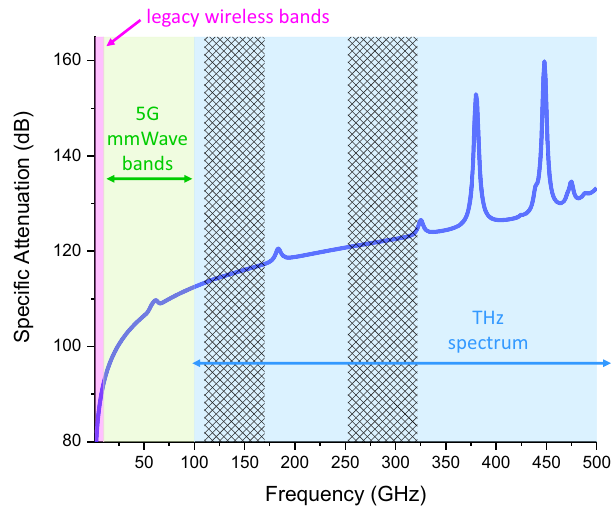
Fig.1|AtmosphereandFSPL. Theattenuationofapropagatingradiowavedueto bothfree-spacepathlossandatmosphericabsorption,foranassumedpropagation distance of 100 m, at a temperature of 15°C and relative humidity of 59%, using a standard atmospheric model (see [10, 11]). The shaded areas indicate the range of frequencies corresponding to legacy wireless systems, the 5G millimeter-wave range, and the THz spectrum. The hatched areas are the two bands of signi fi cant interest for communications mentioned in the